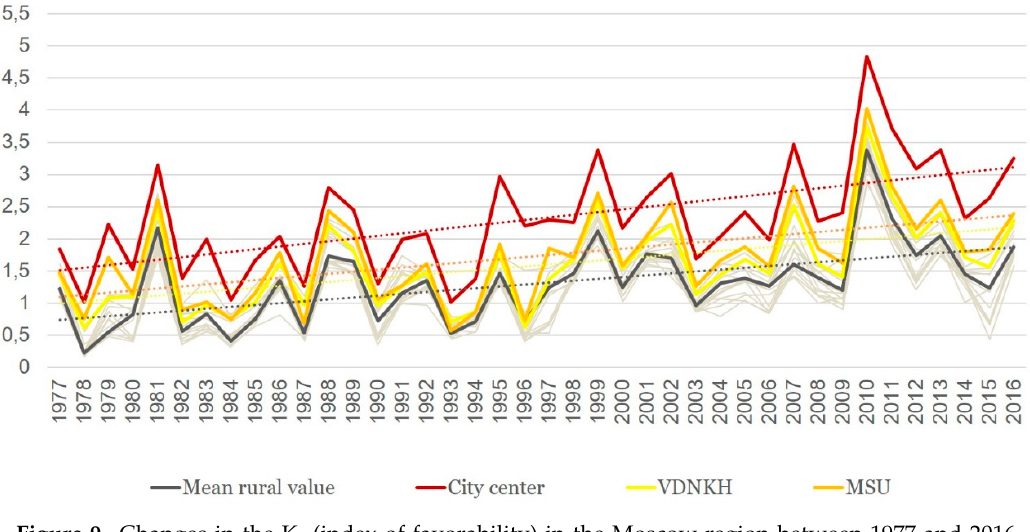
Figure 9. Changes in the K f (index of favorability) in the Moscow region between 1977 and 2016 (dashed lines show linear trends, and thin gray lines indicate the rest of the analyzed stations).